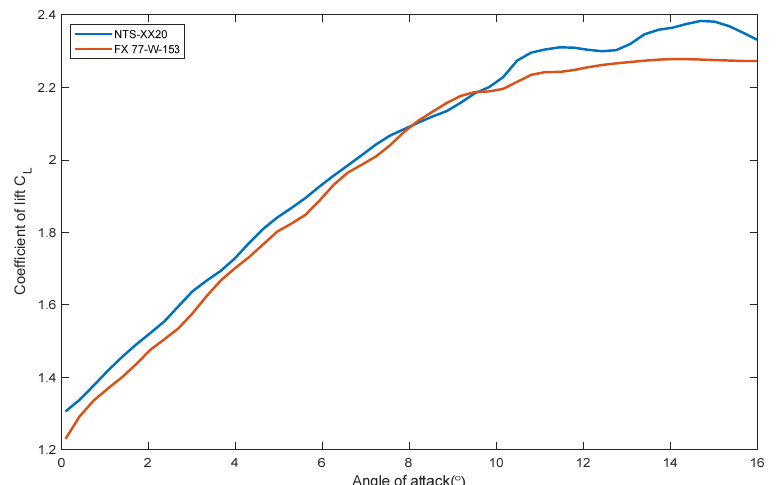
Figure 6. Variation of the coe ffi cient of lift for NTS-XX20 compared with that of FX 77-W-153 at di ff erent AOA and Re = 2 × 106.